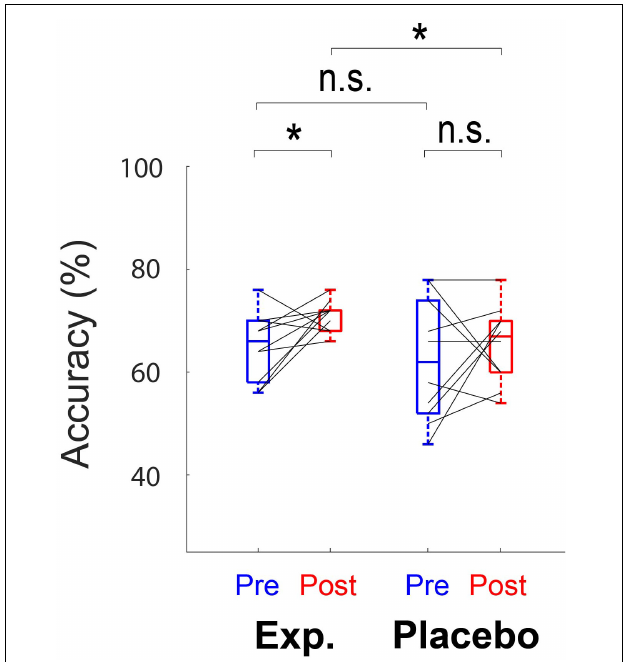
FIGURE 4 | Box plots show the behavioral performance (accuracy) for both the Experimental Group and the Placebo Group. Each box denotes the 25–75th percentile range, and the horizontal bar in the center denotes the median. Solid lines indicate the same subject in different conditions. Mean accuracy significantly differs before and after training in the Experimental Group. *Significant at p < 0.05, n.s., not significant.